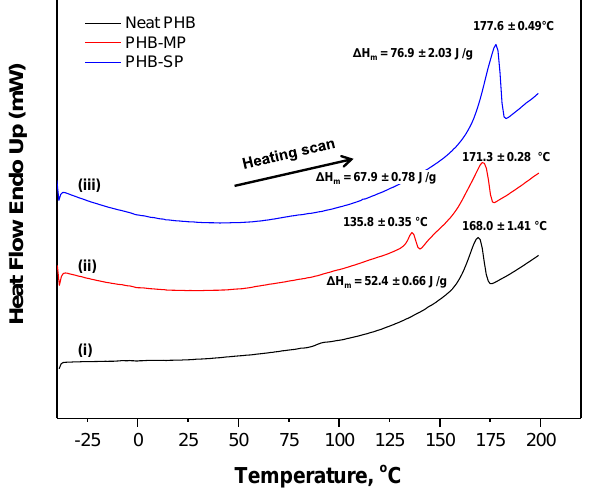
Figure 3. Differential scanning calorimetry (DSC) thermographs of (i) neat PHB, (ii) PHB-MP and (iii) PHB-SP.